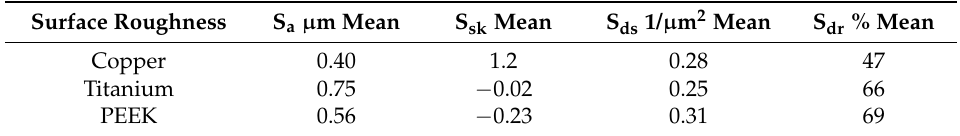
Table 6. Surface roughness